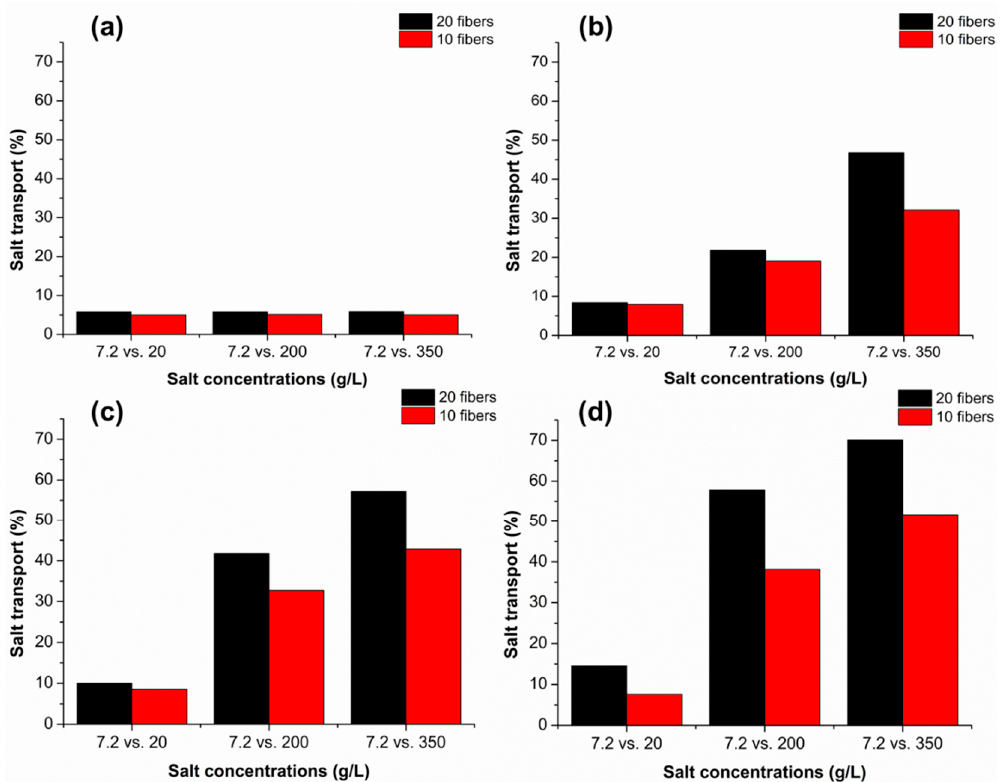
Figure 2. The effect of solution flow rate on the salt pick-up under different salinity gradients in the salt cartridge. Solution flow rates include: ( a ) 0 mL/min, ( b ) 1 mL/min, ( c ) 20 mL/min and ( d ) 100 mL/min.